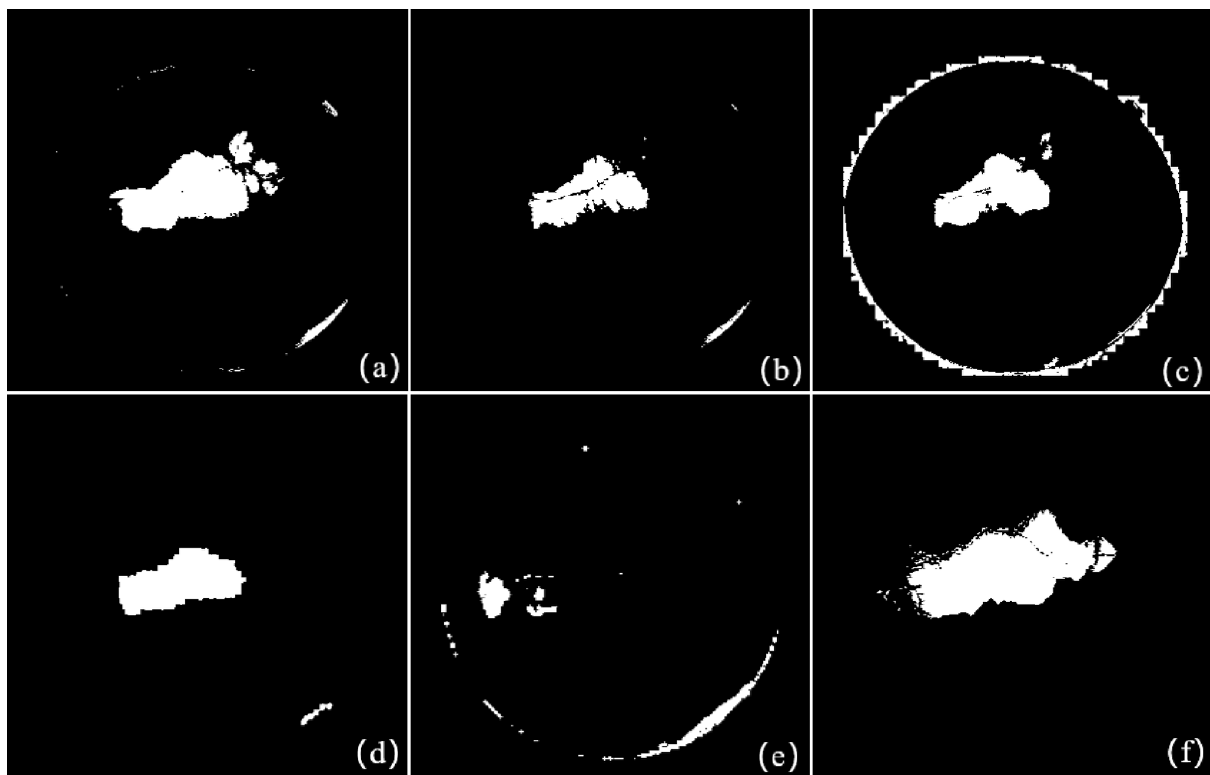
Figure 8. Binary CMs of the pair of images with large lesions in Fig. 6. ( a ) Binary CM of IRHSF; ( b ) binary CM of RPCA; ( c ) binary CM of NRELM; ( d ) binary CM of IRG-McS; ( e ) binary CM of NPSG; ( f ) binary CM of the fusion method of IRHSF and